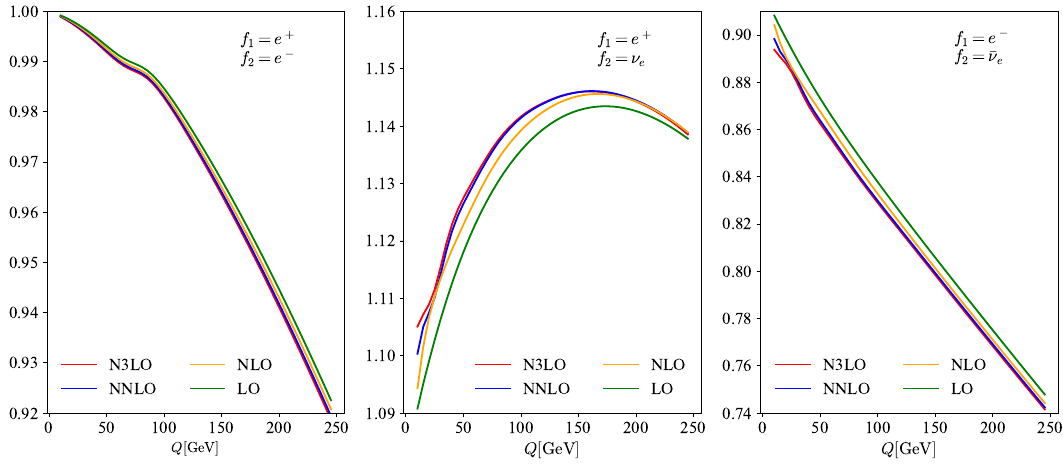
Figure 6 . Ratio of the proton-proton to the proton-anti-proton Σ N k LO